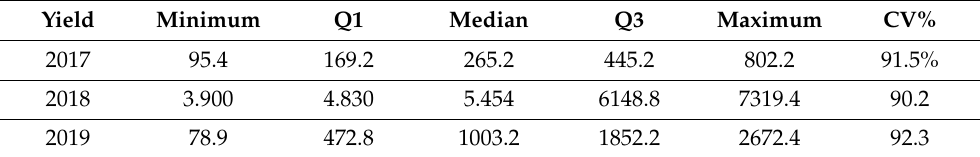
Table 2. Exploratory analysis of the yield variable.